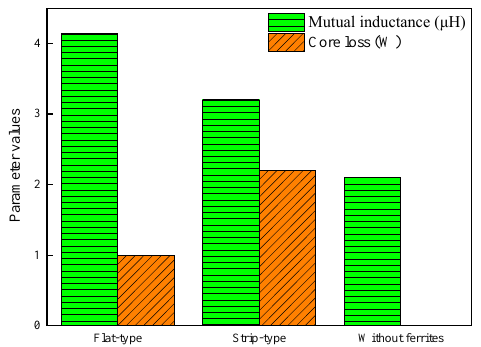
Figure 8. Mutual inductances and core losses of three cases.